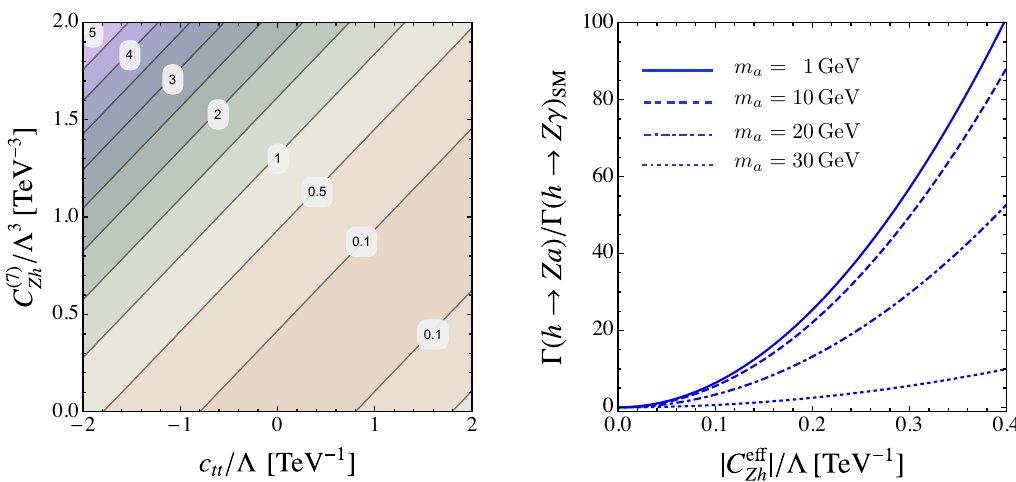
Figure 11 . Left: contours for the ratio (cid:0)( h Za ) = (cid:0)( h Z(cid:13) ) SM in the plane of the Wilson ! ! coe(cid:14)cients c tt and C (7) for m a < 1 GeV and (cid:3) = 1 TeV. Right: the same rate ratio as a function Zh of the e(cid:11)ective Wilson coe(cid:14)cient C e(cid:11) for di(cid:11)erent ALP Zh